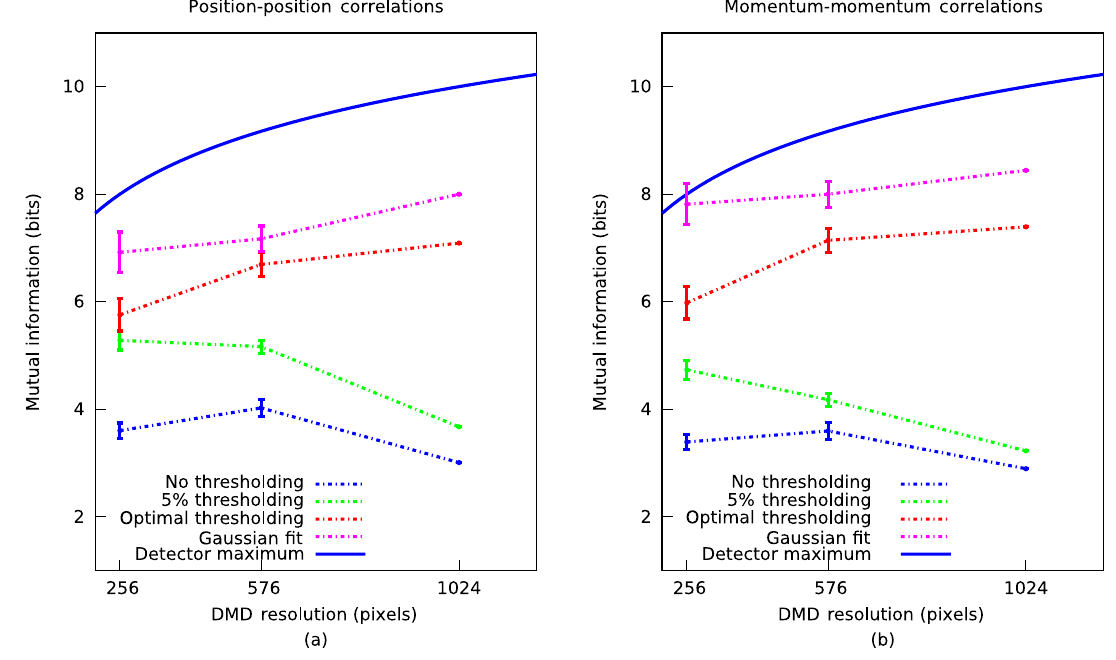
FIG. 6. Mutual information between signal and idler photons for (a) position-position and (b) momentum-momentum representa- tions are presented as a function of detector resolution. Three levels of thresholding are shown, as well as a fit to Eq. (5). The dashed lines are guides for the eye. The error bars enclose 2 standard deviations from the expected uncertainty from simulations (not performed for n ¼ 1024 ). The solid curve represents the maximum possible value for a particular detector resolution, given perfect correlations and uniform